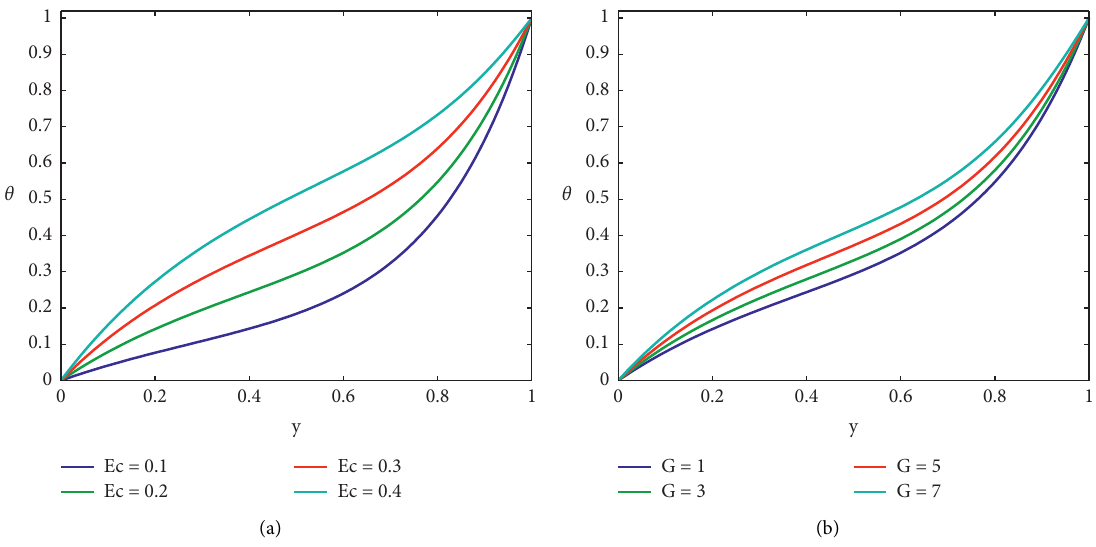
Figure 5: (a) Effect of Ec on the “temperature distribution” when G � 1. (b) Effect of G on the “temperature distribution” when Ec � 0 . 2.